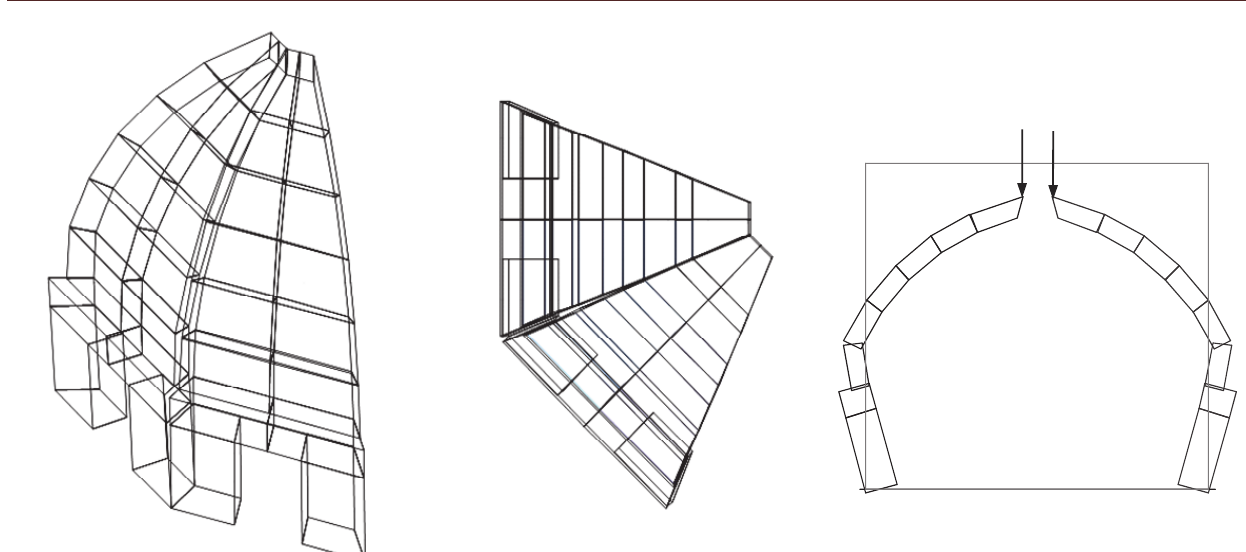
Figure 17: Collapse mechanism for case 11 (failure at ribs / Lf=2 / Nh=0 / sT=2.5 / multiplier α